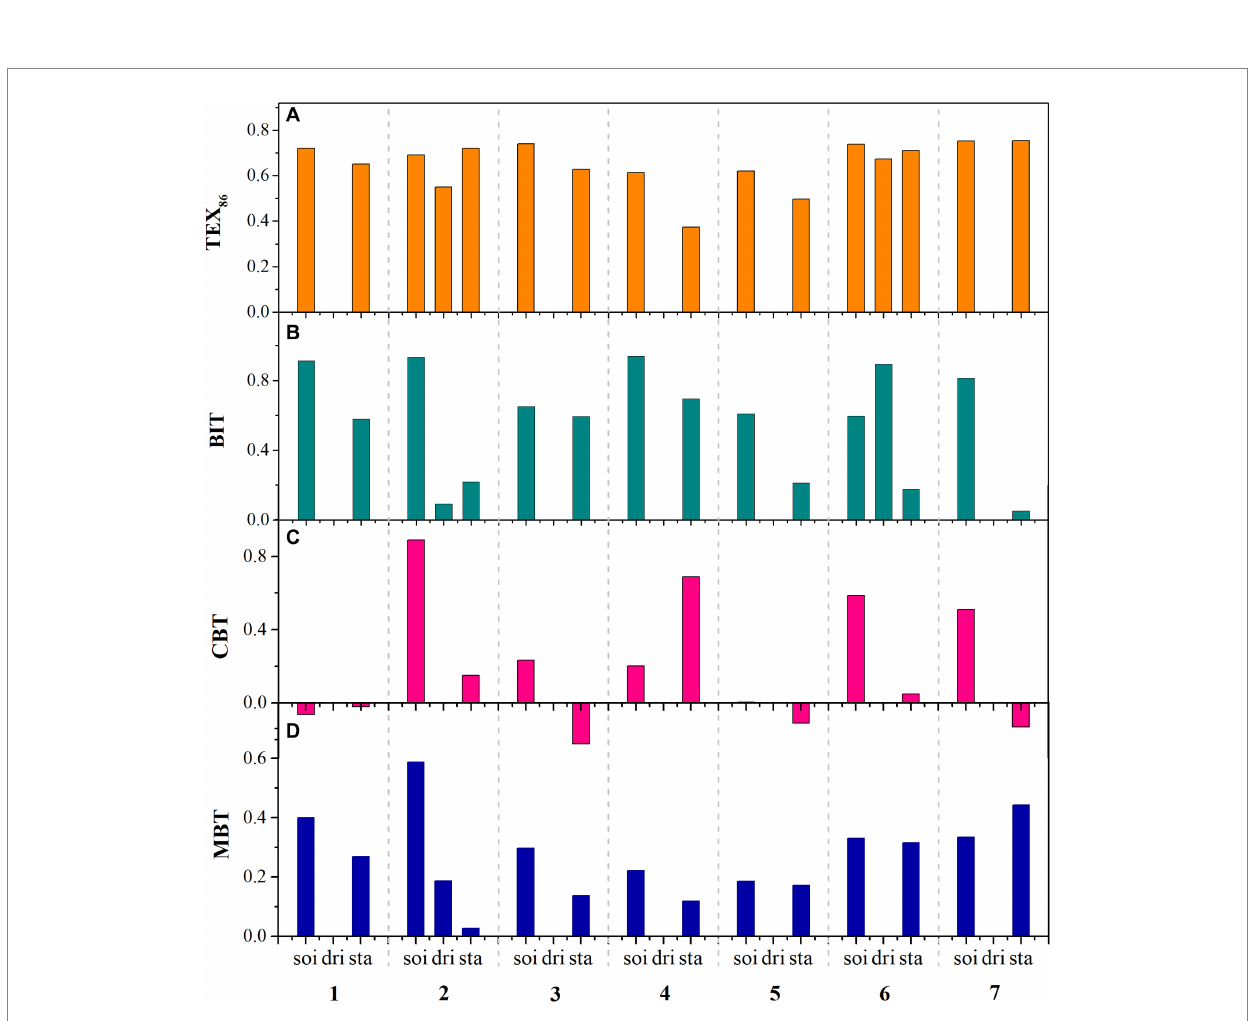
FIGURE 5 Comparison of GDGT proxies for soils (soi), dripping water (dri), and speleothems (spe) (1, Heshang Cave, Yang et al., 2011; 2, Heshang Cave, Zhang et al., 2020; 3, Wombeyan Caves; 4, Pooles Cavern; 5, Lower Balls Mine; 6, Cathedral Cave; 7, Gaden Cave; data 3–7 from Blyth et al.,